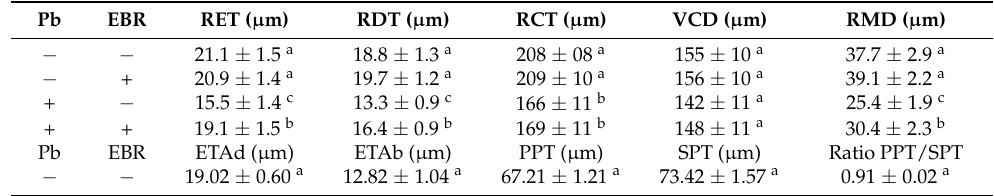
Table 2. Root and leaf structures in tomato plants treated with EBR and subjected to Pb